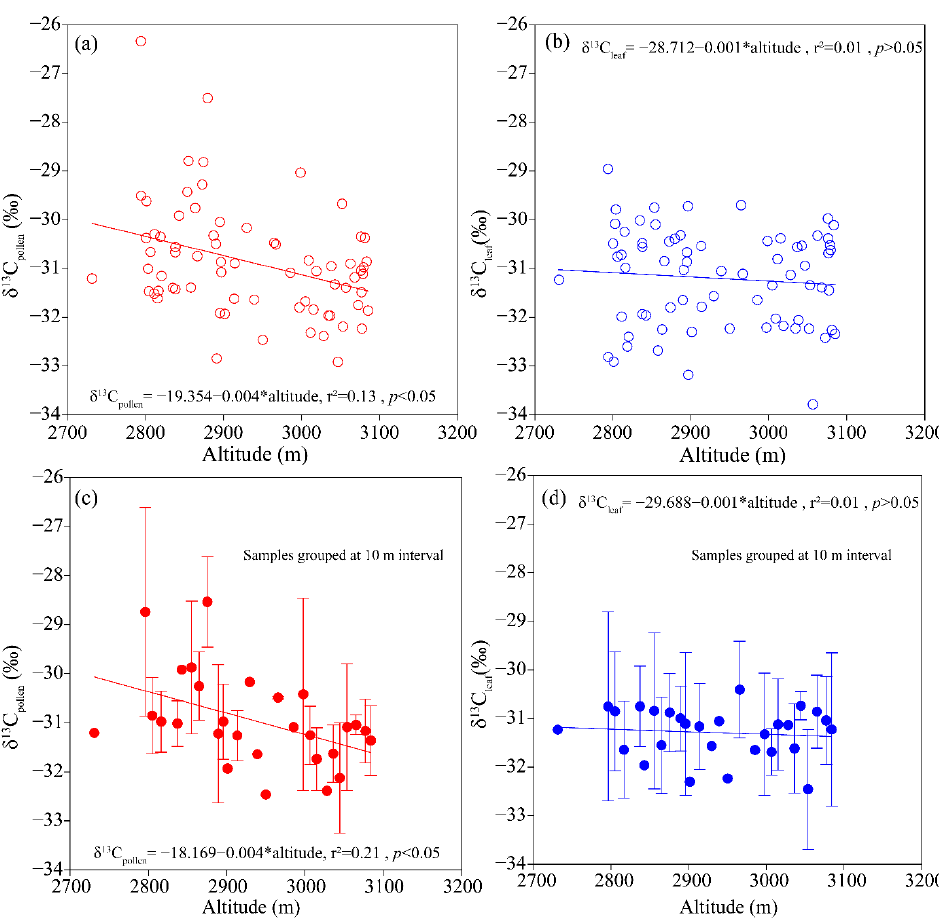
Figure 4. The relationships between pollen and leaf δ 13 C values of Pinus yunnanensis and altitude in northwestern Yunnan, China. ( a , b ) samples with original data; ( c , d ) samples grouped at 10 m inter- val of altitude with their means and one standard deviation.